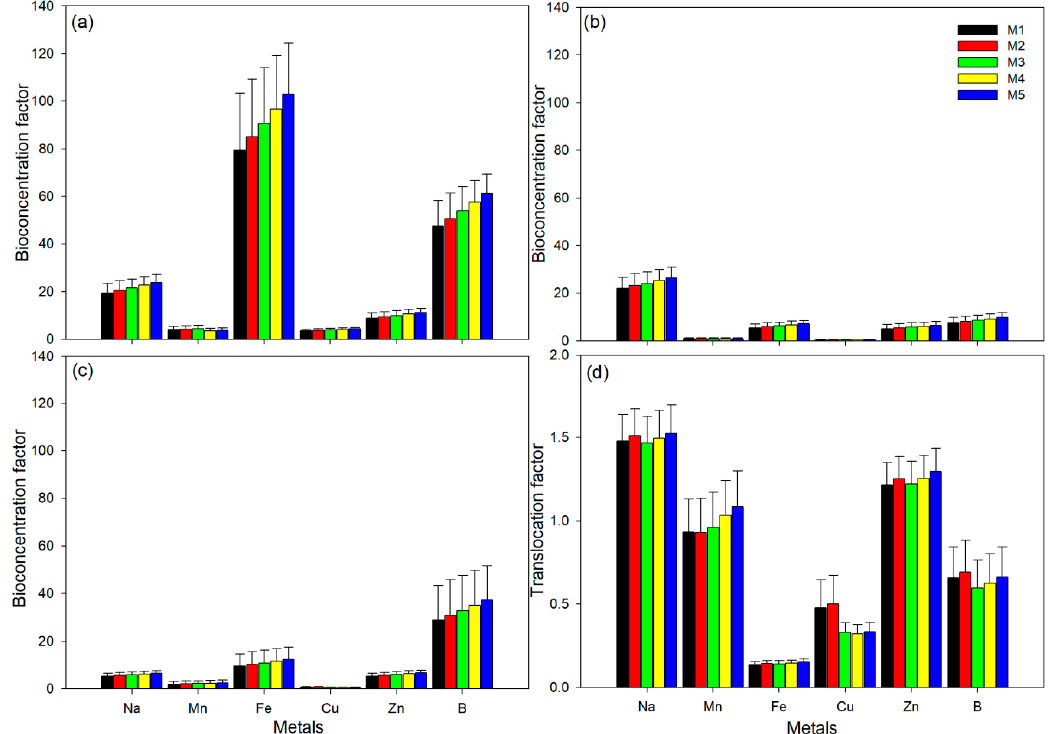
Figure 3. Mean (± standard error) site (M1–M5) variation of bioconcentration (BCF) and translocation (TF) factors of Phragmites australis sampled from Mvudi River, South Africa: ( a ) root BCF, ( b ) stem BCF, ( c ) leaves BCF, and ( d ) TF.